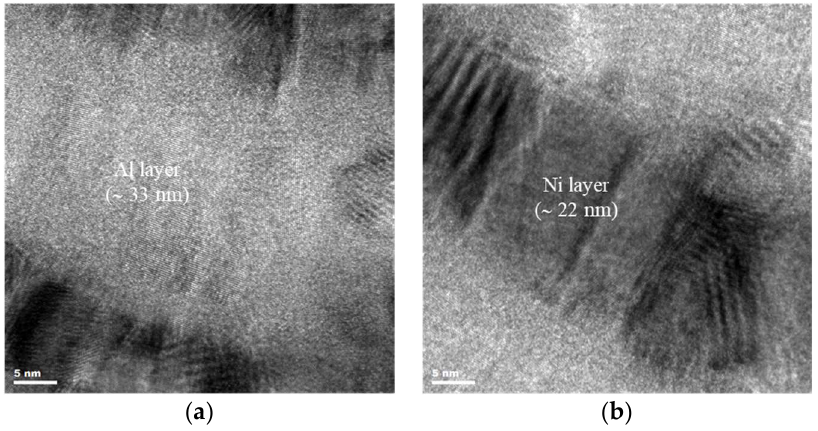
Figure 7. HRTEM images of the Al / Ni(V) film with Λ = 50 nm ( V S = − 40 V, ion gun o ff ). ( a ) Al layer highlighted; ( b ) Ni layer highlighted.